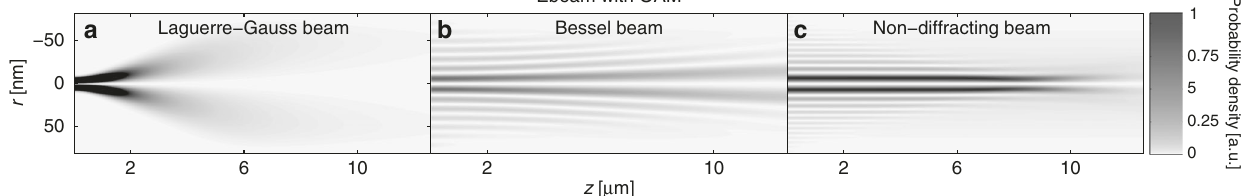
Fig. 5 Evolution of multi-electron beams with non-zero OAM. a – c Propagation of a multi-electron beam with OAM = 1 and initial Laguerre – Gauss and Bessel wavefunctions, respectively. The repulsion among the electrons makes the Laguerre – Gauss EBeam diffracts very fast, while even the Bessel beam broadens considerably. c Propagation of the non-diffracting multi-electron beams with OAM = 1 and the wavefunction represented by the green curve in Fig. 1c. The beam preserves its shape for a large distance in spite of the repulsion among